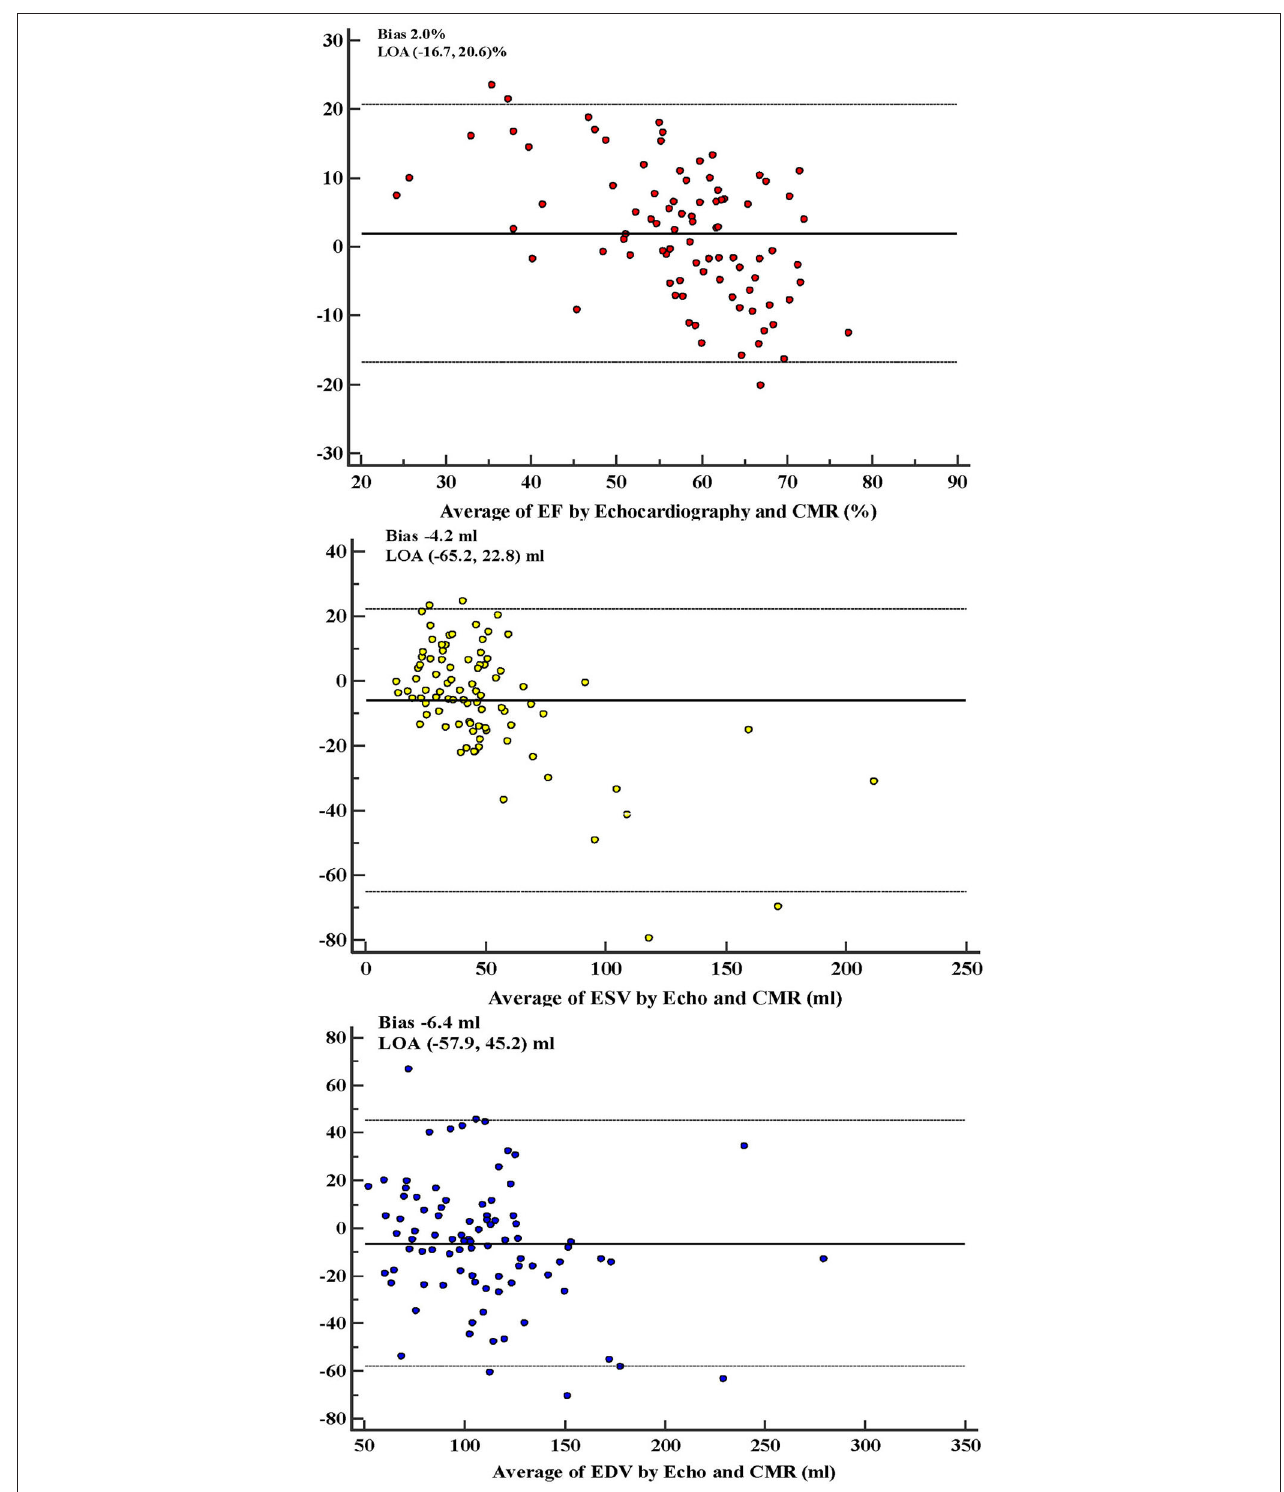
FIGURE 3 | Bland–Altman analysis for left ventricular functions between echocardiography and CMR. Bias and 95% LOA were expressed as the mean and 95% confidence interval of the differences in normally distributed values (i.e., EF and EDV), as median and 2.5th − 97.5th percentiles of the differences in non-normally distributed values (i.e., ESV). EF, ejection fraction; ESV, end-systolic volume; EDV, end-diastolic volume; CMR, cardiovascular magnetic resonance; LOA, limits of agreement.